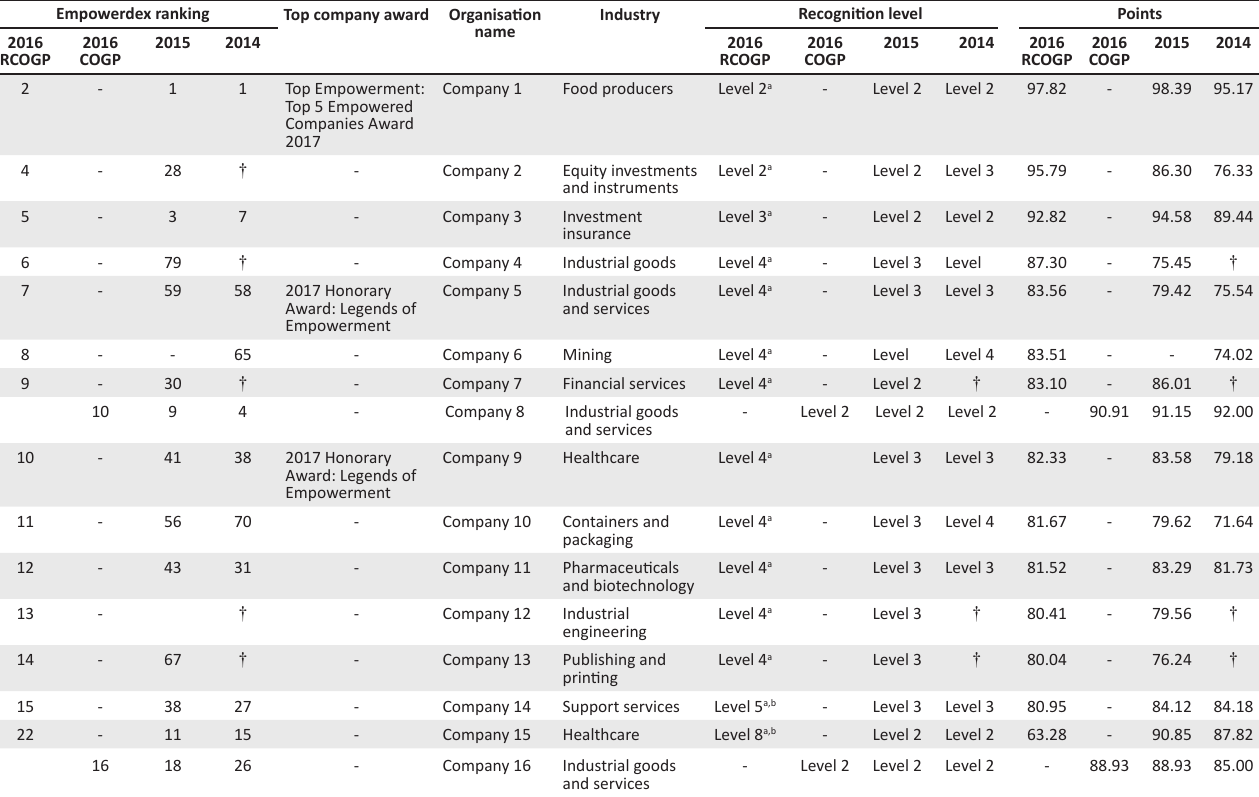
TABLE 2: Ranking of ideal participant organisations. Empowerdex ranking Top company award Organisation